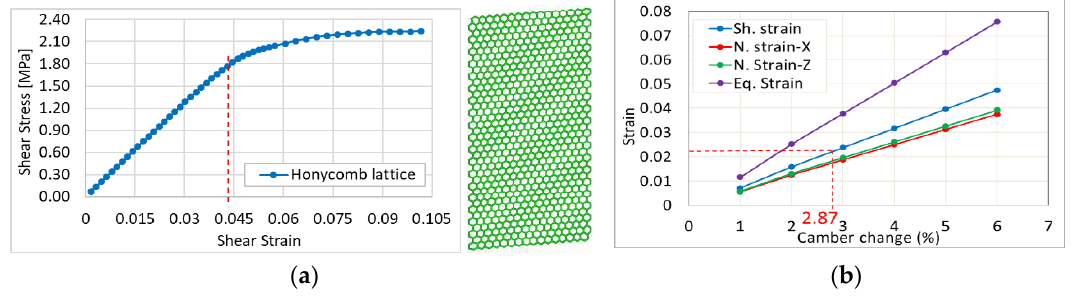
Figure 12. ( a ) In-plane shear stress/strain curve and ( b ) percentage of camber change vs. corresponding strain.